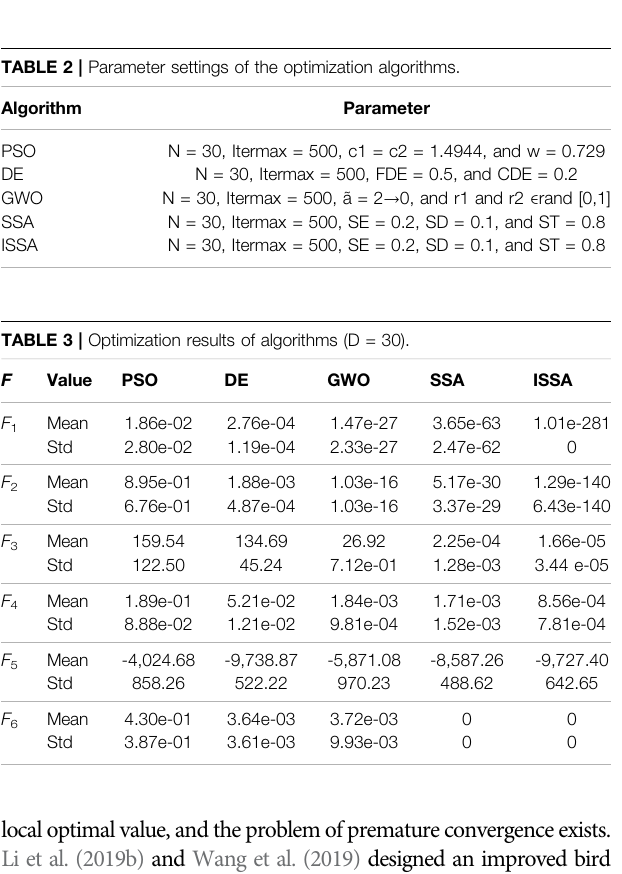
swarm algorithm (IBSA) and an arti fi cial bee colony (ABC) algorithm